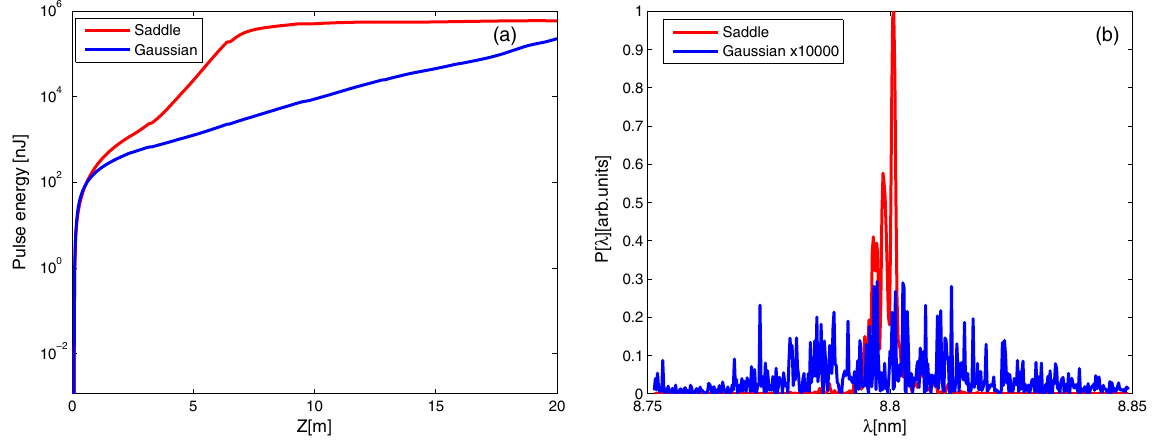
FIG. 8. Comparison of final 8.8 nm radiation pulse energy (a) and spectra (b) of SXFEL with a single-stage HGHG. The spectra are exported at the undulator position of 10 m, where the saddle distribution is almost saturated, while the Gaussian one is still in exponential gain